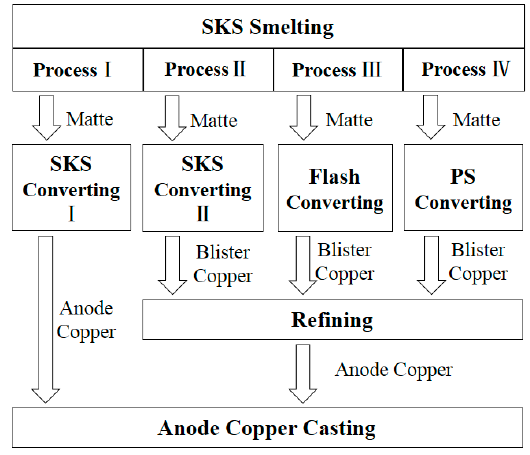
Figure 1. Four typical SKS (Shuikoushan) processes in China.